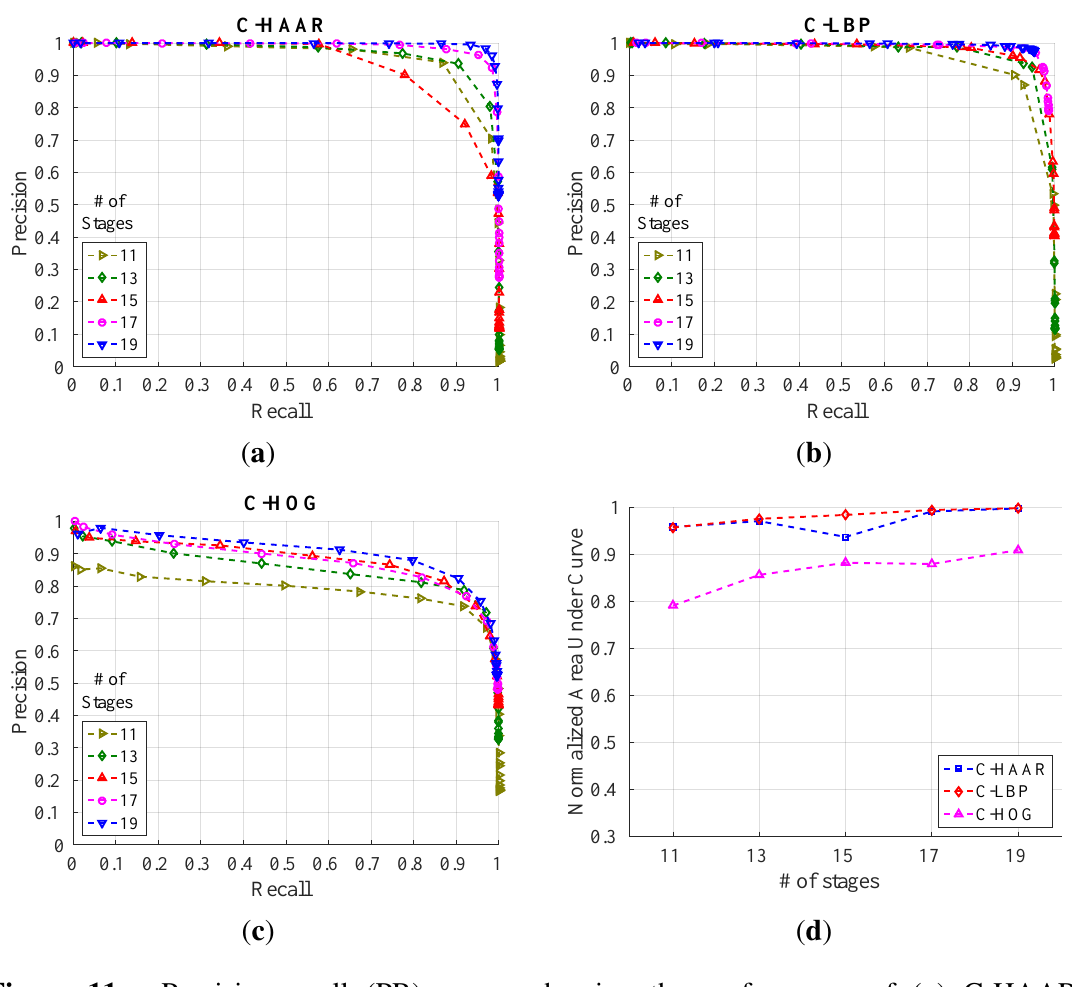
Figure 11. Precision-recall (PR) curves showing the performance of ( a ) C-HAAR, ( b ) C-LBP and ( c ) C-HOG for different numbers of stages on indoor test videos; ( d ) normalized areas under the PR curves in ( a – c ). Table 3. Performance of the methods indoors, reported as F-score values. Bold indicates best